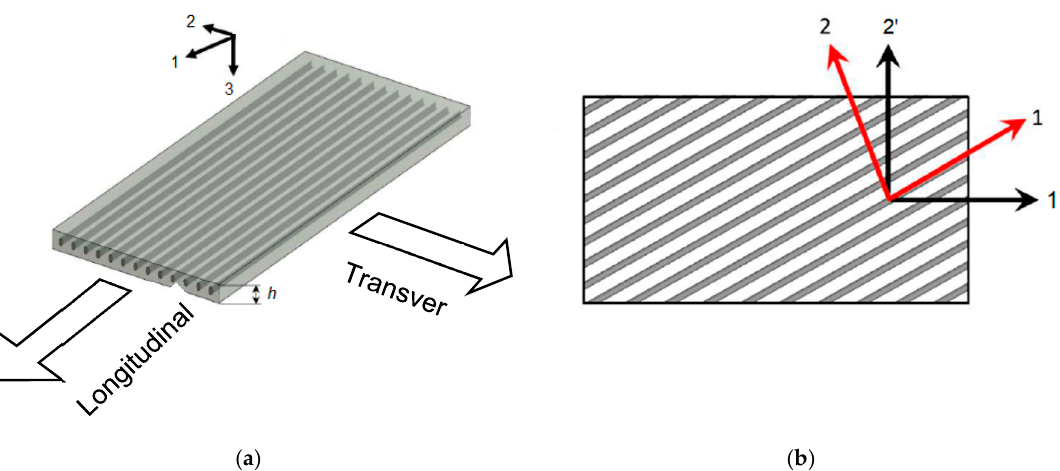
Figure 3. In a unidirectional fibrous composite lamina: ( a ) principal material axes; ( b ) rotated axes.